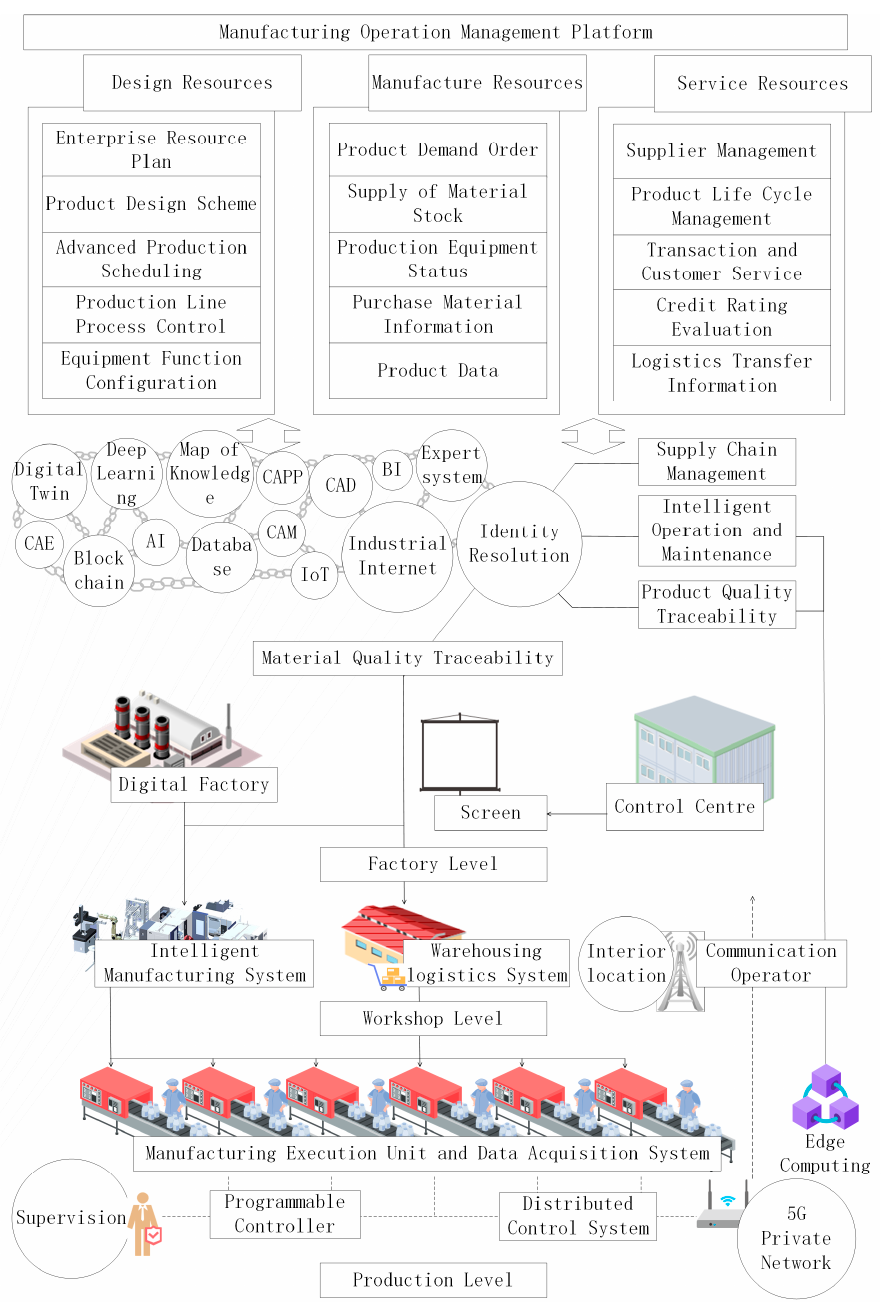
Figure 1. Architecture of the full connection digital factory.